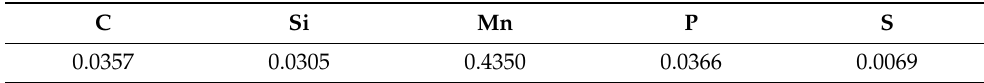
Table 1. Chemical composition of HX220 in mass